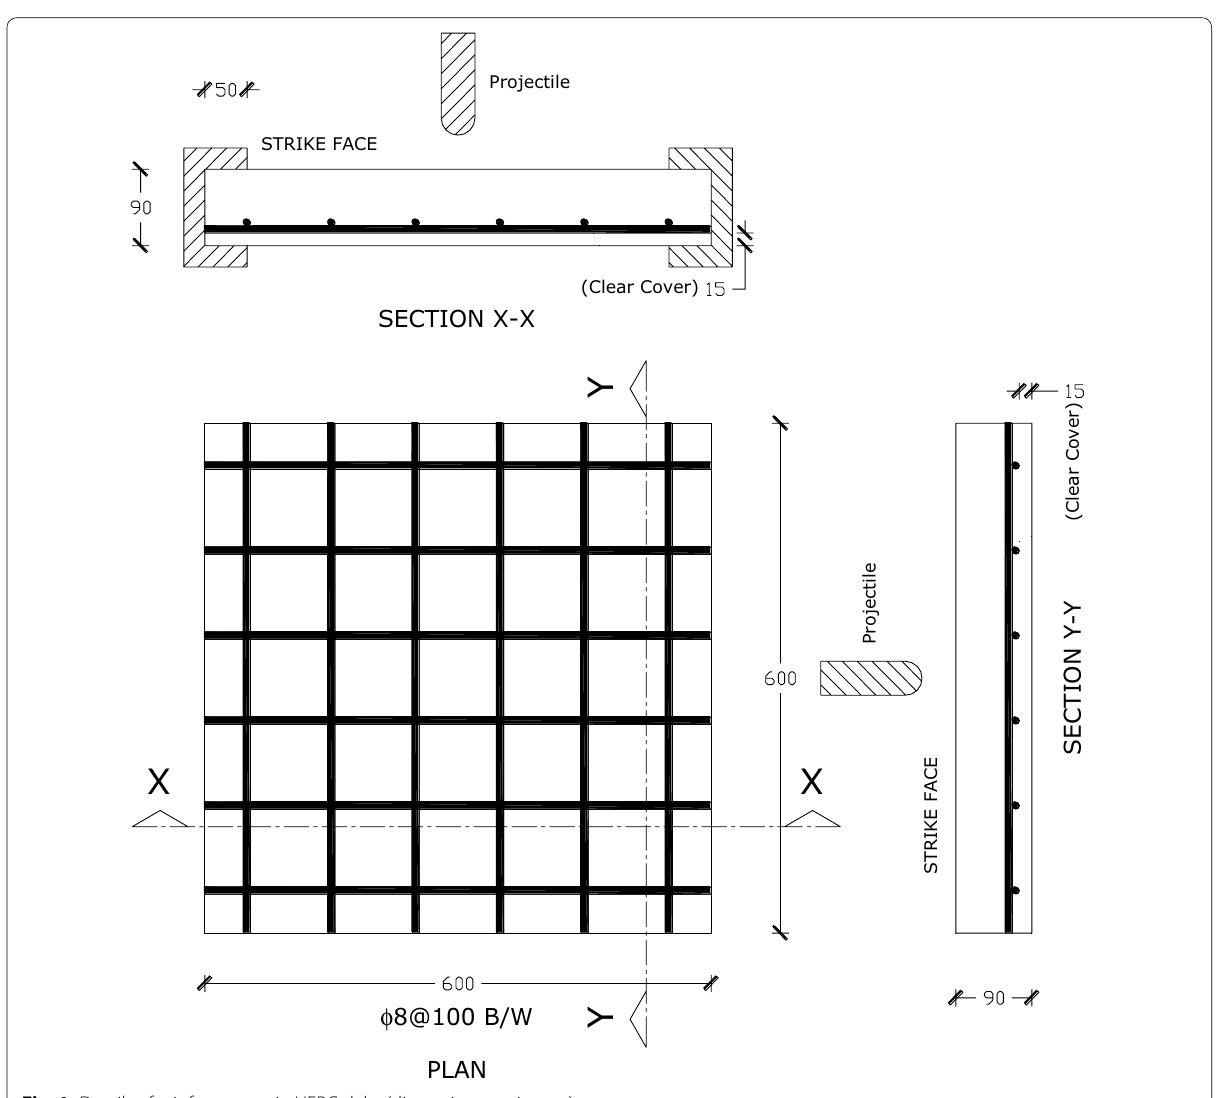
Fig. 1 Details of reinforcement in HFRC slabs (dimensions are in mm).